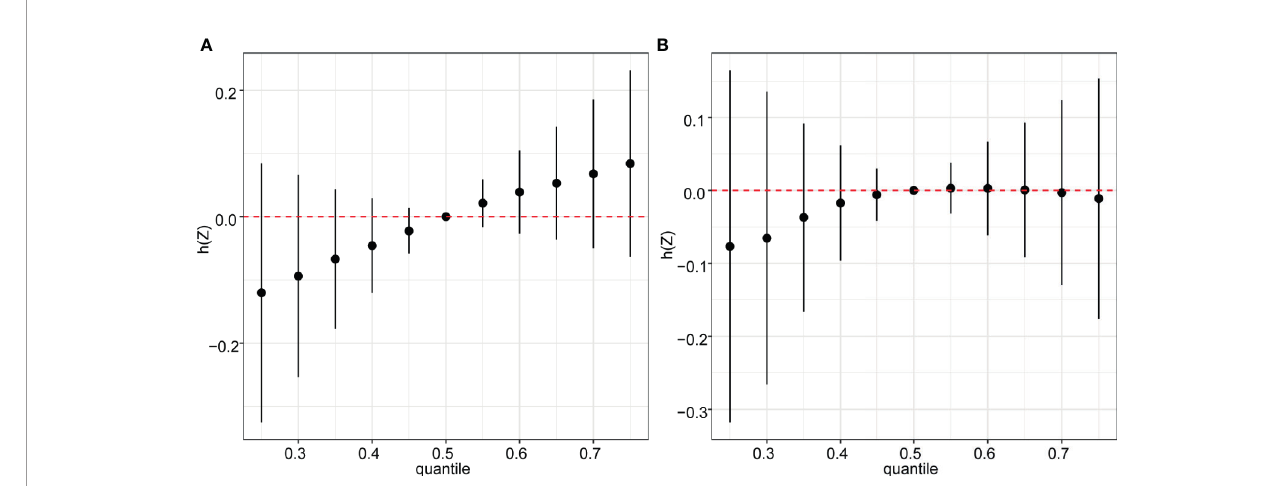
FIGURE 3 | Overall risk (95% CI) of the mixture on uterine leiomyomata (A) and endometriosis (B) when comparing all the chemicals at different percentiles with all of them fi xed at the median level. Models were adjusted for age, ethnicity, BMI group, ovary removal, female hormone usage, pregnant status, menopause status, and log-transformed urinary creatinine